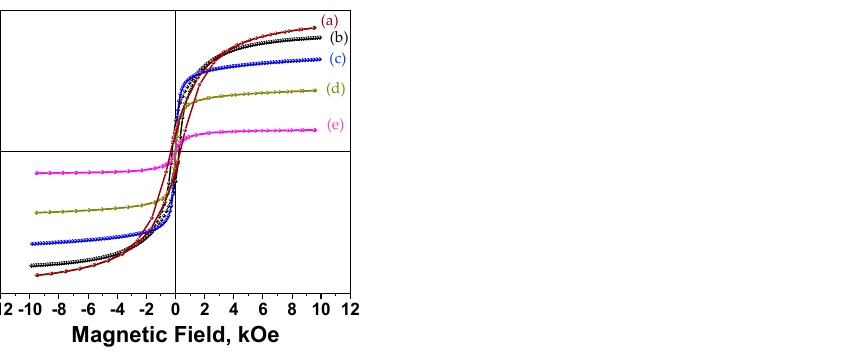
Figure 3. Room temperature hysteresis loops of the Fe-based core/shell nanoparticles synthesized at 315 °C ( a ), 285 °C ( b ) 260 °C ( c ) 240 °C ( d ) and 180 °C ( e ).